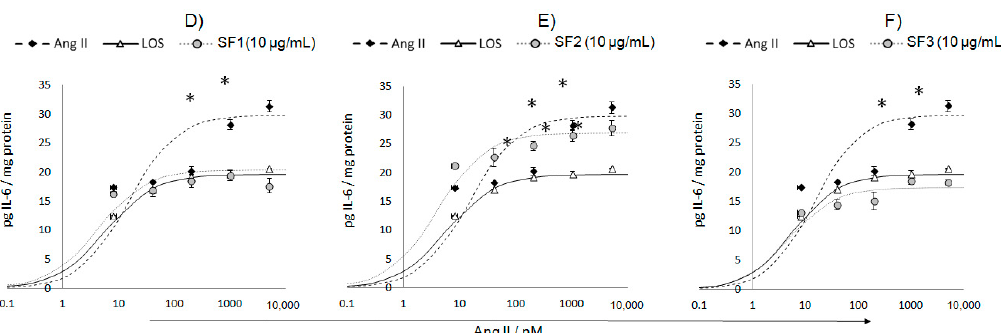
Figure 1. Concentration–response curves of the subfractions evaluated on Ang II (angiotensin II)-induced IL-6 (Interleukin 6) production, 12 h after treatment. ( A – C ) Effect of 0.08 μ g/mL of SF1 (subfraction 1), SF2, and SF3; ( D – F ) Effect of 10 μ g/mL of SF1, SF2, and SF3. Human microvascular endothelial cells-1 (HMEC-1) cells were co-cultured with the concentrations of Ang II specified above. Losartan (LOS) was used as a positive control. Data are reported as mean ± SD (standard deviation) and were analyzed by ANOVA and the post-hoc Tukey test. n = 5, * p < 0.05 vs. control (Ang II-free).